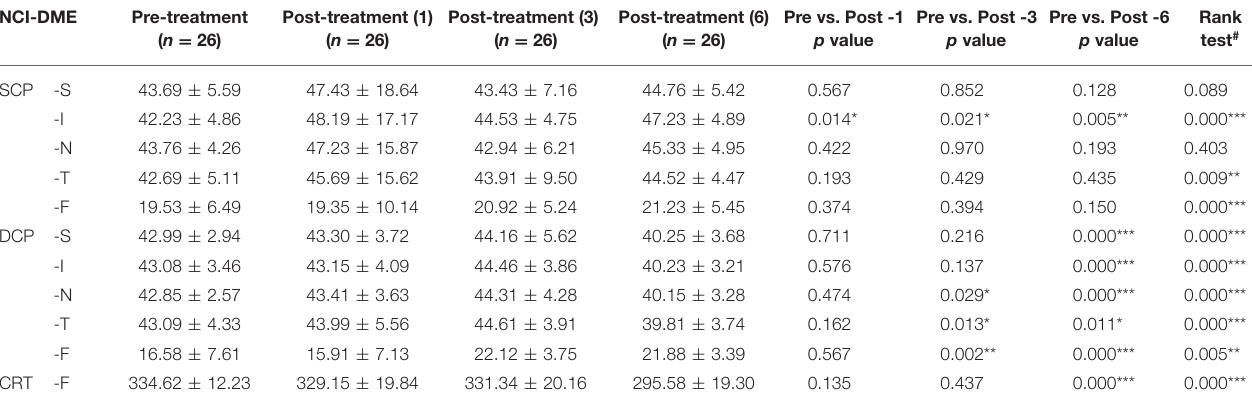
TABLE 3 | The change vessel density of superficial retinal capillary plexus and deep retinal capillary plexus after conbercept treated NCI-DME for 1, 3, and 6 months, compared to pre-treatment.